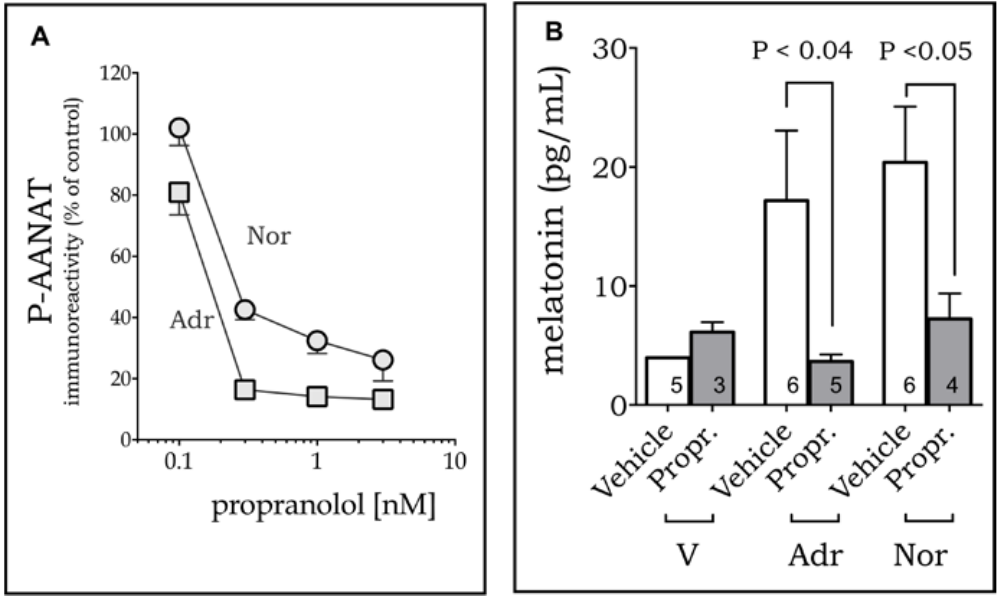
Figure 3. β -adrenoceptors mediate melatonin synthesis in RAW 264.7 macrophages. Propranolol (Prop.; 30 min) inhibits P-AANAT expression ( A ) and melatonin synthesis ( B ) induced by adrenaline (Adr; 0.2 nM; squares) and noradrenaline (Nor; 0.4 nM; circles). V = vehicle (0.001% ethanol). Data represent mean ± SEM ( A )—each point is the mean of three to six independent experiments; ( B )—the number of experiments is shown inside the bars).